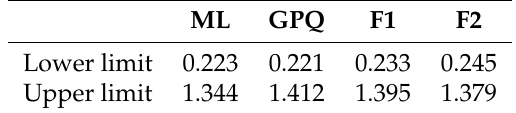
Table 8. 95% confidence intervals for the prevalence ratio in the migraine headaches